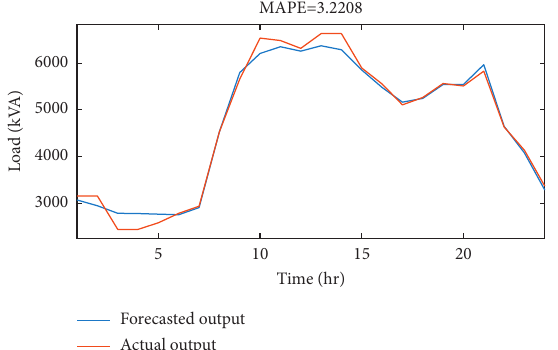
Figure 23: The Fuzzy-PSO prediction of Patriots’ Day load.